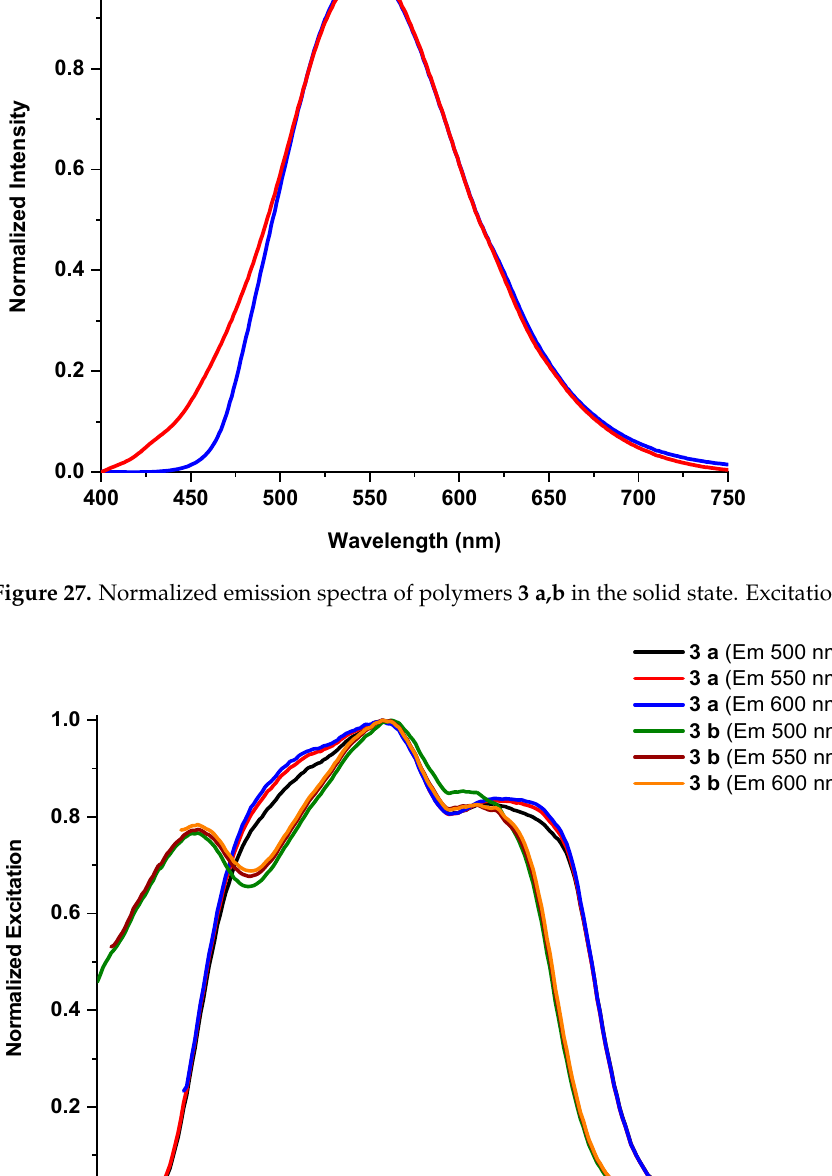
Wavelength (nm) Figure 29. Emission spectra of polymer 3 a in the solid state at different temperatures. The fluorescence decays obtained for polymers 3 a,b at 436 and 540 nm are shown in Figure 30. The decays are nonexponential. The two-exponential model is sufficient to fit